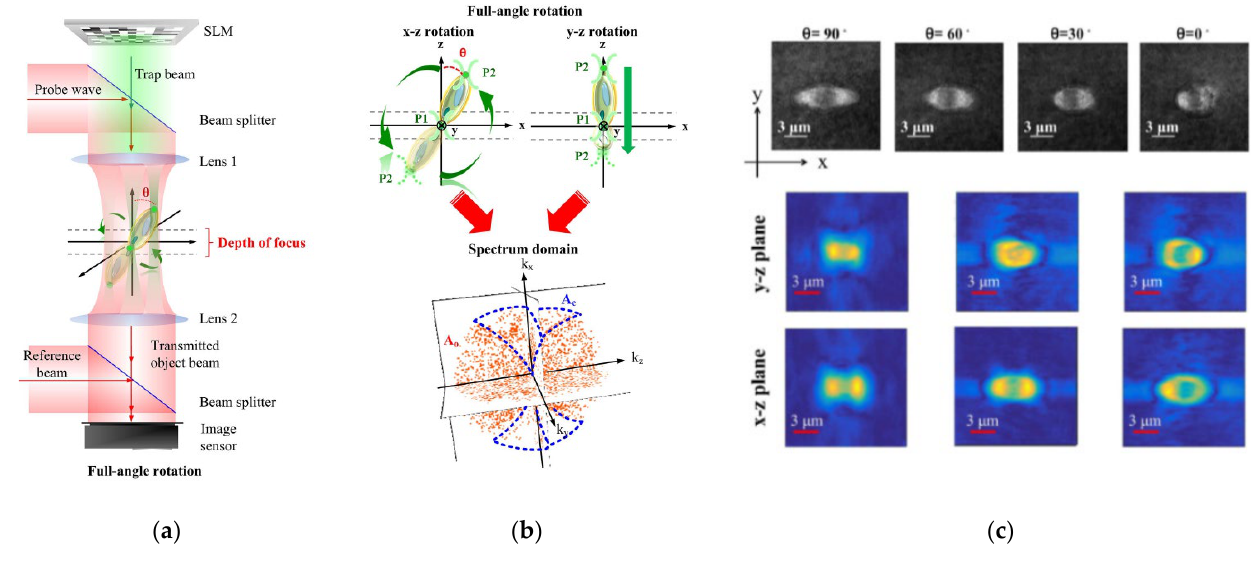
Figure 13. HT-HOT joint system [67] . ( a ) Optical system. ( b ) The schematic diagram. ( c ) The measuring index distributions of yeast cell.